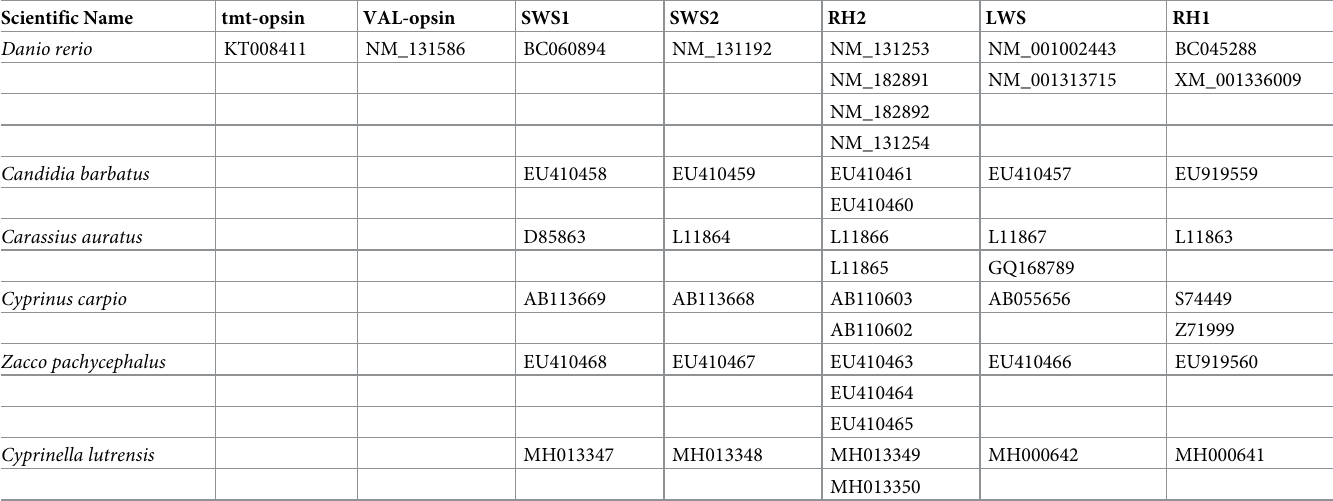
Table 1. Opsin genes from cyprinid species analyzed in this